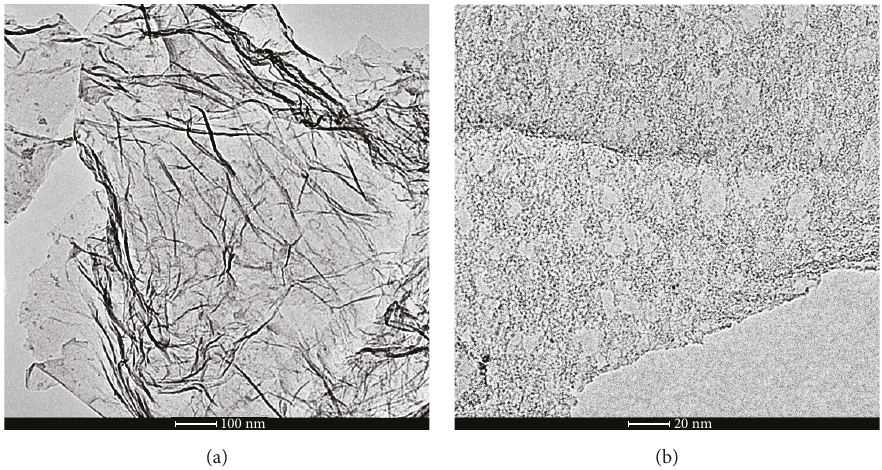
Figure 1: TEM microphotographs of (a) thermally reduced graphene oxide (RGO) and (b) graphene nanoplatelets (GNP).